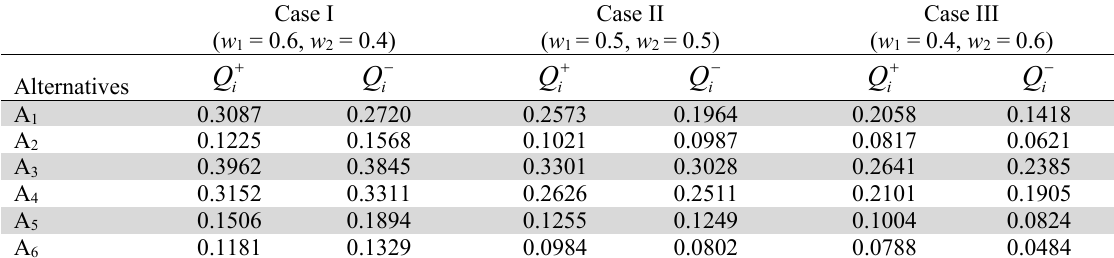
Weighted sum and weighted product values of the